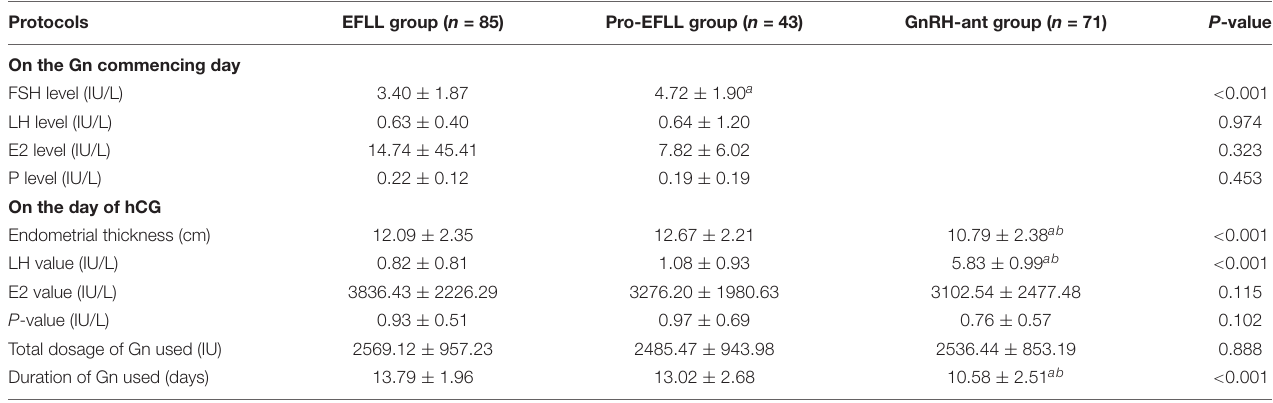
TABLE 2 | Comparison of stimulation variables between the three groups.